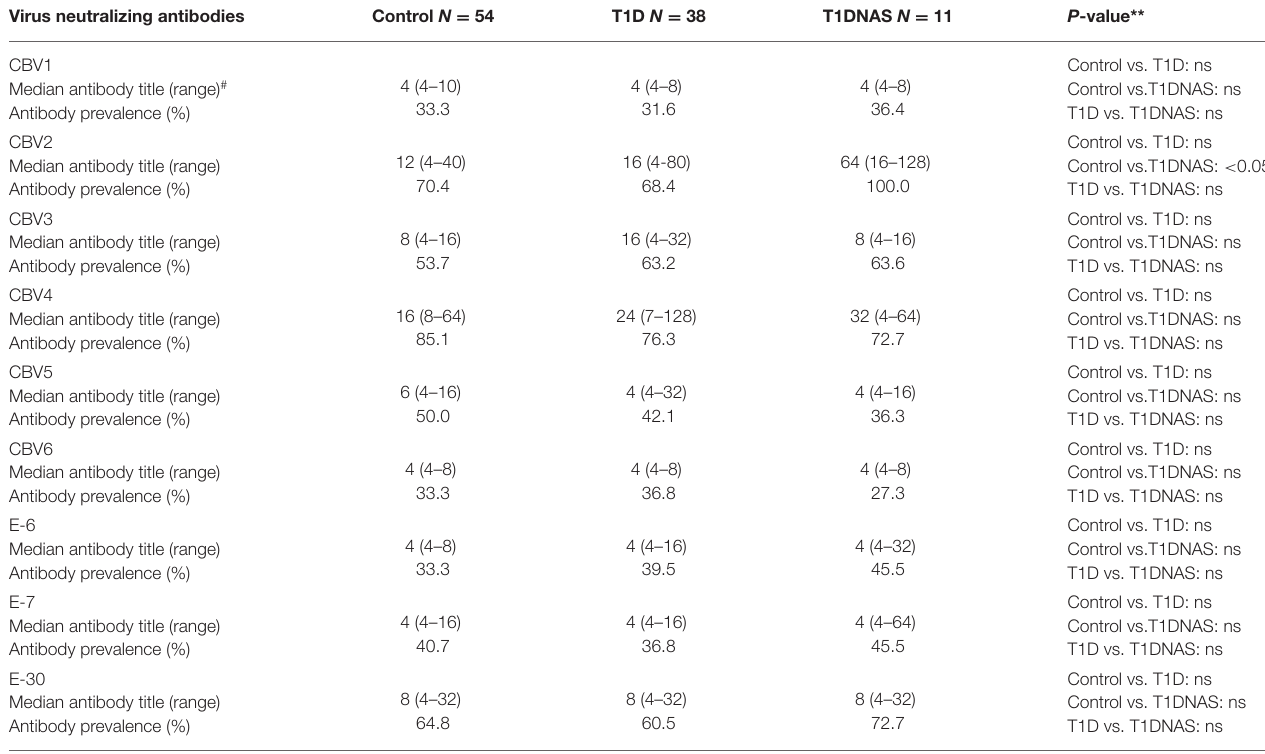
TABLE 2 | Neutralizing antibodies* against different enteroviruses serotypes in control subjects, type 1 diabetes (T1D) patients from multiplex families and their non-affected siblings (T1DNAS). Virus neutralizing antibodies Control N = 54 T1D N = 38 T1DNAS N = 11 P